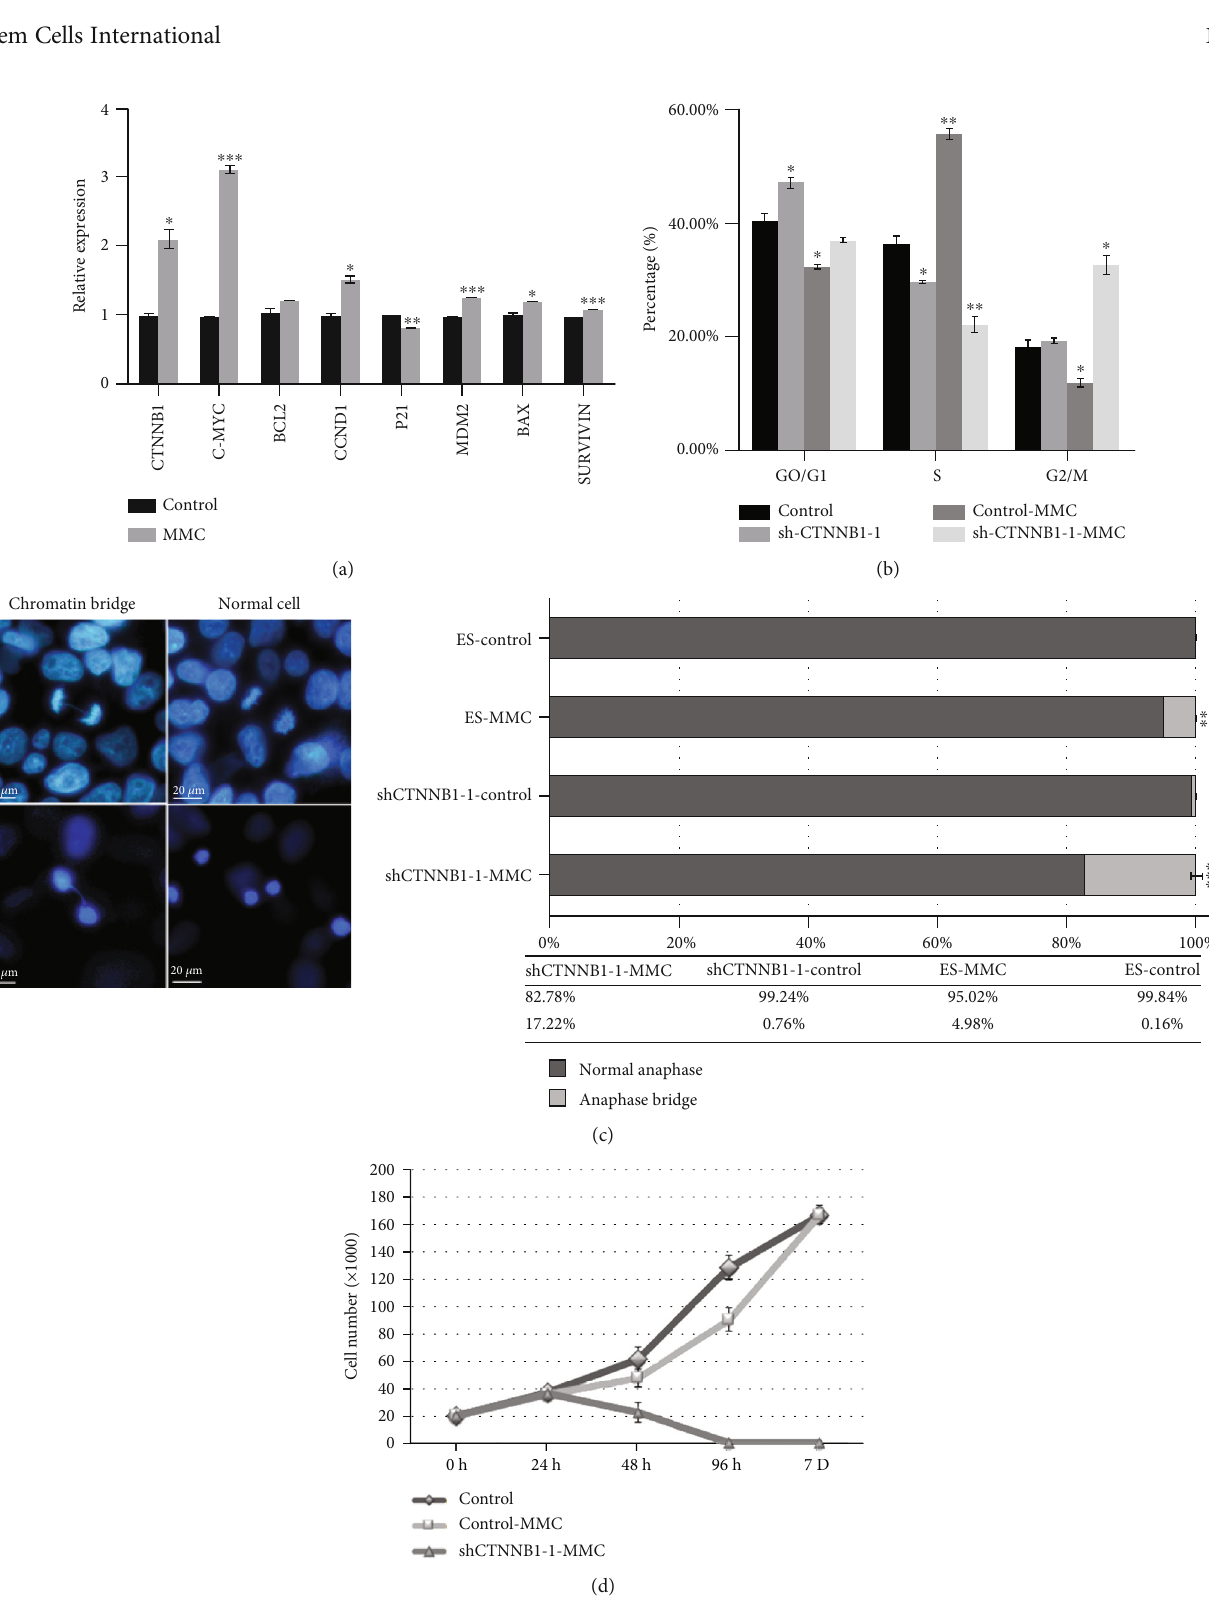
Figure 5: MMC-induced malignant transformation and BFB in hESCs. (a) qRT-PCR analysis of genes expressed in 0.001 μ g/ml MMC- treated cells after 10 passages. (b) Cell cycle analysis of MMC-treated cells. (c) Chromatin bridge analysis was performed in hESCs after 0.001 μ g/ml MMC treatment for 48 h. Nuclei were stained with DAPI (blue) ( scale bar = 20 μ m ). The total number of cells in anaphase and anaphase bridge was counted. (d) Cell growth curves of MMC-treated cells. The error bars represent mean ± SD from three independent experiments ( n = 3 , ∗ p < 0 : 05 , ∗∗ p < 0 : 01 , ∗∗∗ p < 0 : 001 , relative to control